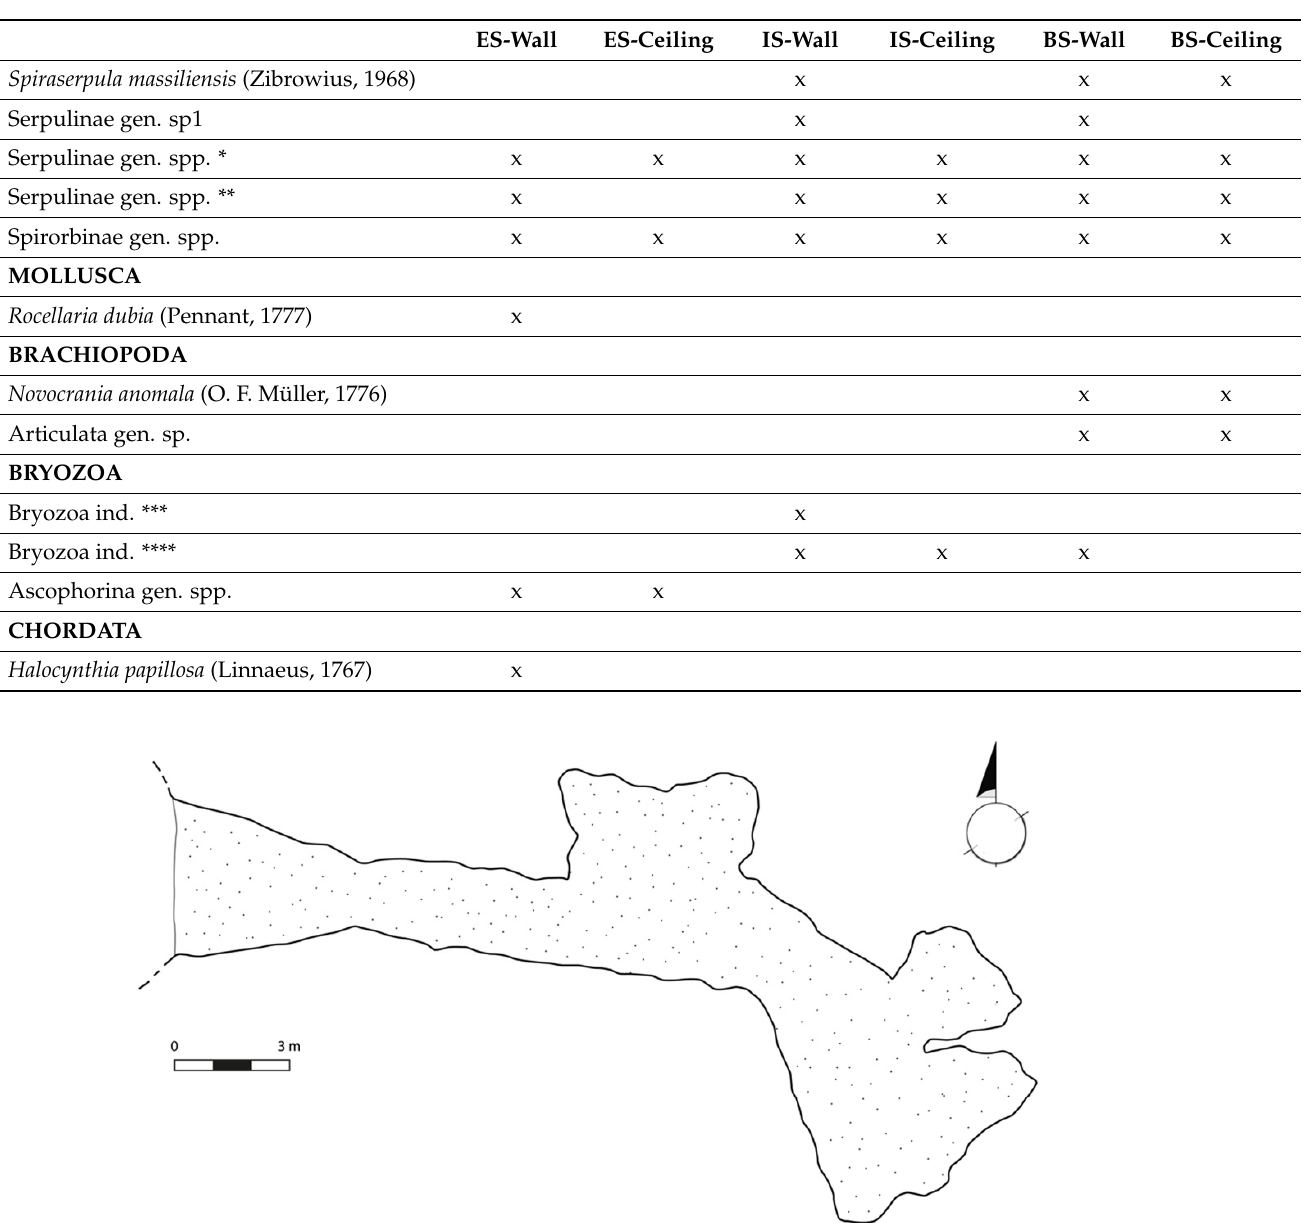
Figure 5. Species richness of the benthic organisms on the wall and ceiling of the three sectors of the Elle cave: ES: Entrance; IS: Intermediate sector; BS: Bottom sector.